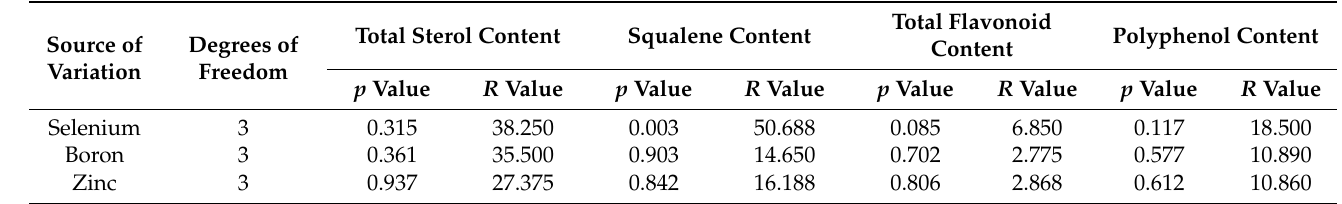
Table 5. Analysis of variance and extreme value analysis of trace elements and components in Camellia